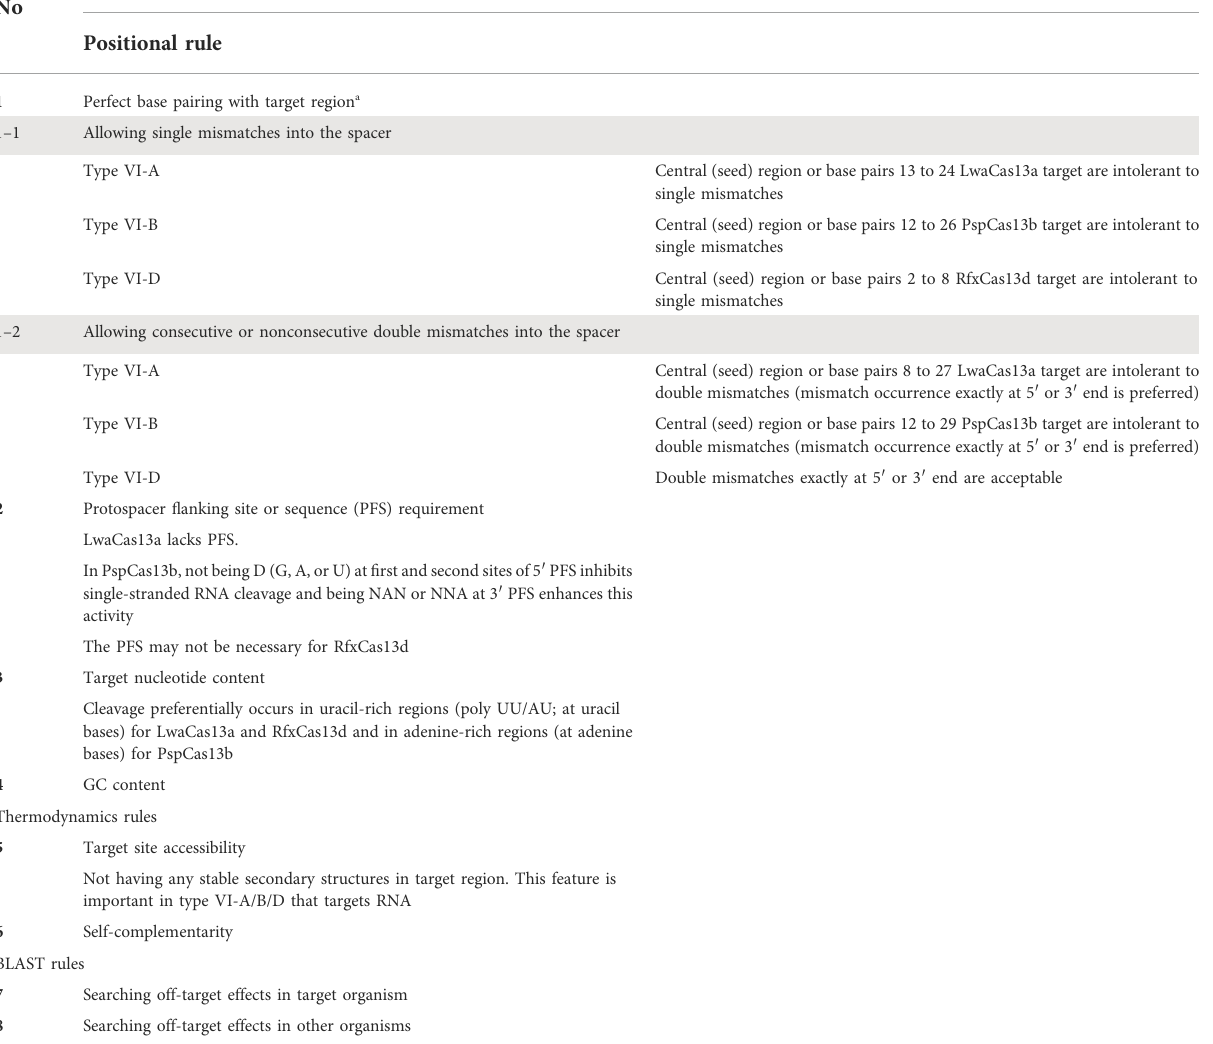
TABLE 3 Principles of crRNA designing for type VI-A/B/D CRISPR-Cas